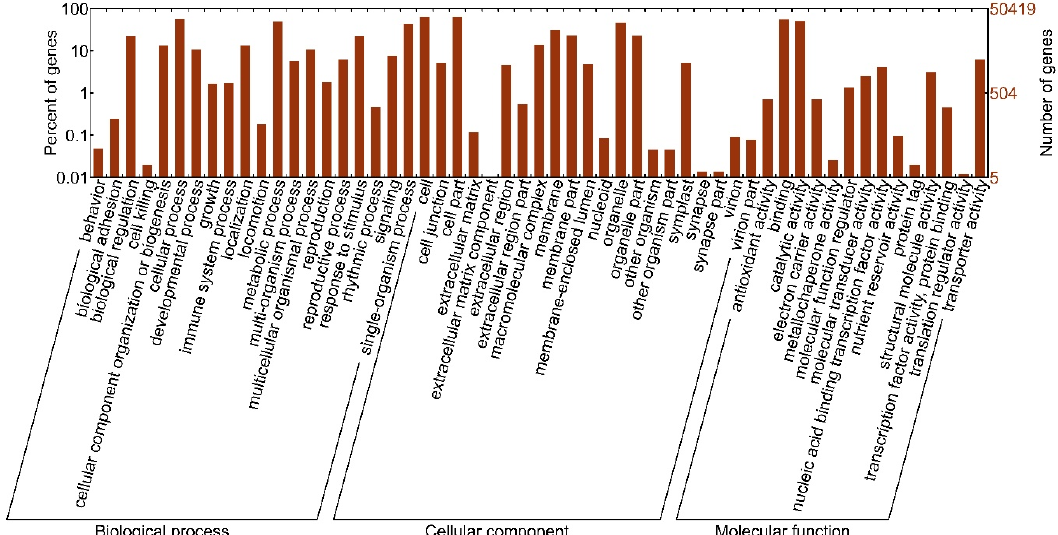
Figure 2 . Gene Ontology (GO) annotations of Styrax japonicus unigenes. The left y-axis indicates the percentage of a specific category of genes in each main category. The right y-axis represents the amount of unigenes in a category.